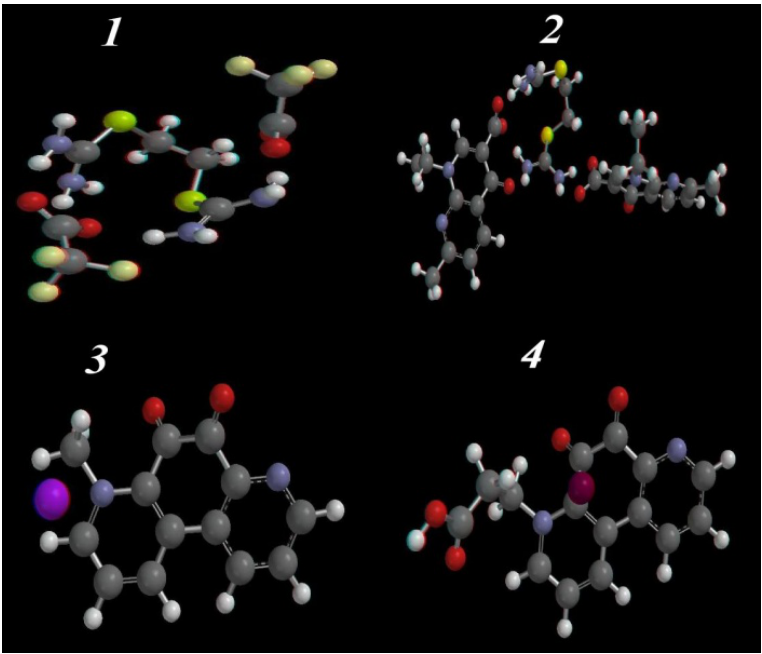
Figure 3. Ball and stick rendering for the most stable conformer of the isothiouronium salts 1 – 4 as calculated by PM3 semi-empirical molecular orbital